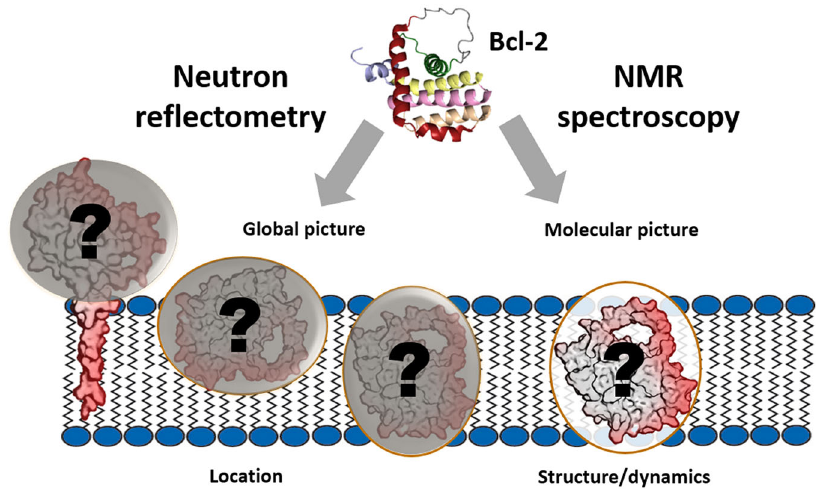
Fig. 1 Schematic diagram of approaches used to probe the Bcl-2 protein ’ s structure and dynamics in a membrane environment. NR (neutron re fl ectometry) provides a global picture of the membrane, including locations of its molecular compounds and their volumetric contributions, as shown in this schematic diagram of the Bcl-2 protein (in tail-anchored and membrane-embedded positions). NMR provides complementary structural and dynamic information at atomic to entire protein molecule levels. The schematic Bcl-2 structure shown is based on a model of Bcl-2 (derived from PDB_ID 1YSW), including its fully fl exible loop domain